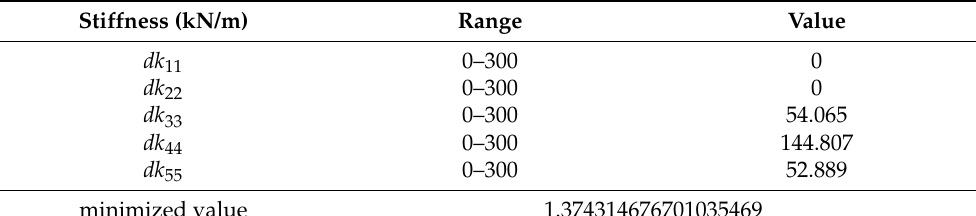
Table 17. Parameters of supporting stiffness.